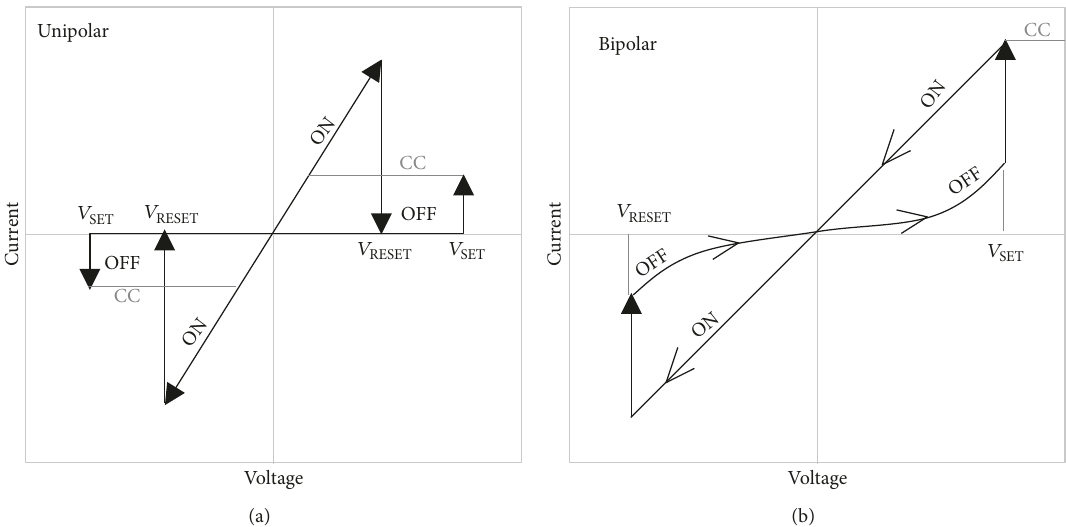
Figure 1: 𝐼−𝑉 diagrams showing the (a) unipolar and (b) bipolar operation modes for ReRAM devices where no dependence of the “pinched hysteresisloops” tofrequencyisinvolved(DCconditions).Theunipolarmodeisabletopromoteresistiveswitchingusingapositiveornegative polarity with 𝑉 SET > 𝑉 RESET and CC SET < CC RESET